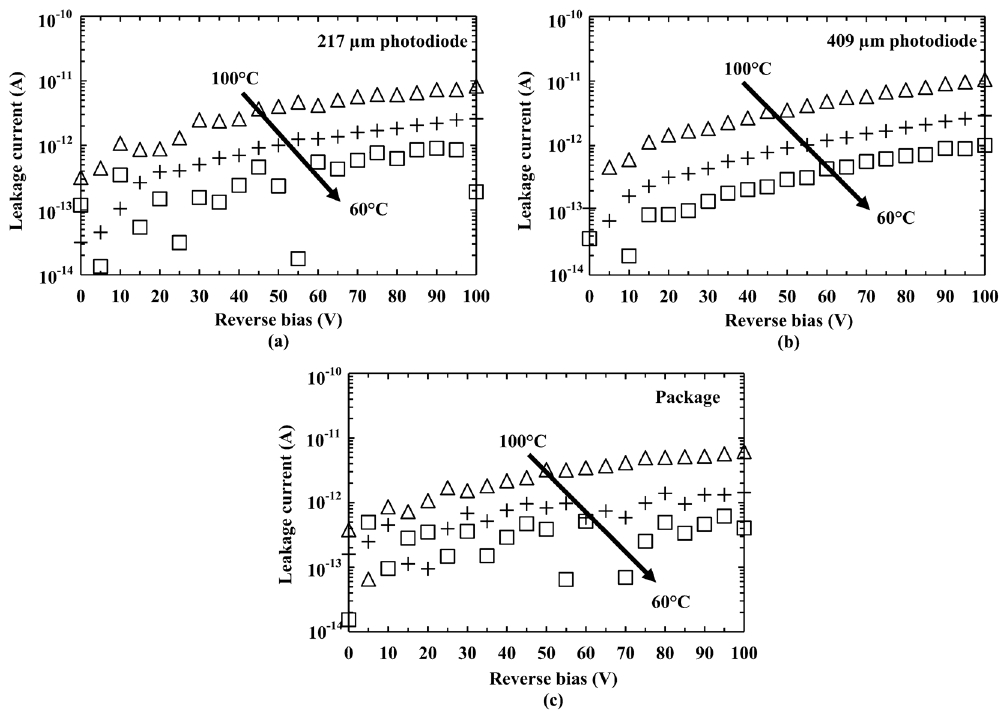
Figure 2. Leakage currents as functions of reverse bias for ( a ) packaged 217 µ m diameter detector (including package leakage), ( b ) packaged 409 µ m diameter detector (including package leakage), and ( c ) the measured leakage current contribution in (a) and (b) from the package itself (as measured using a package pin without a wire-bonded device). In each case the measurements are shown at temperatures of 100 °C, 80 °C, and 60 °C. At temperatures < 60 °C, the currents were too small to be reliable measured using the available experimental set